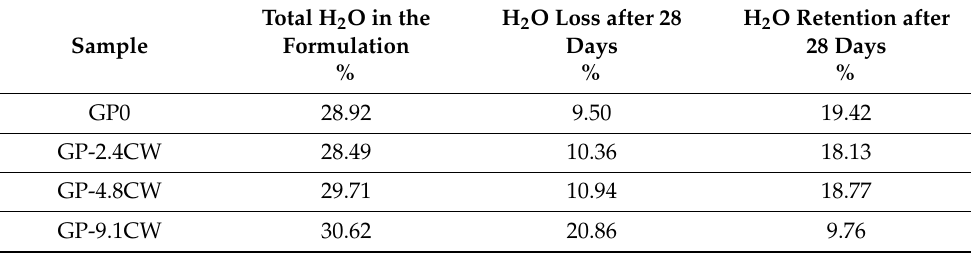
Table 2. Percentages of total water, water loss and retention in the different formulations after 28 days of ageing.